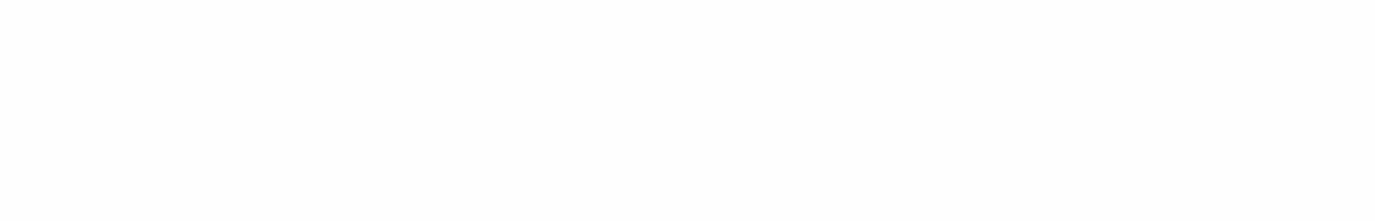
FIGURE 7 A multivalued relation between the front velocity and its curvature for the parameters used in the domain split- ting simulation shown in Fig. 8.